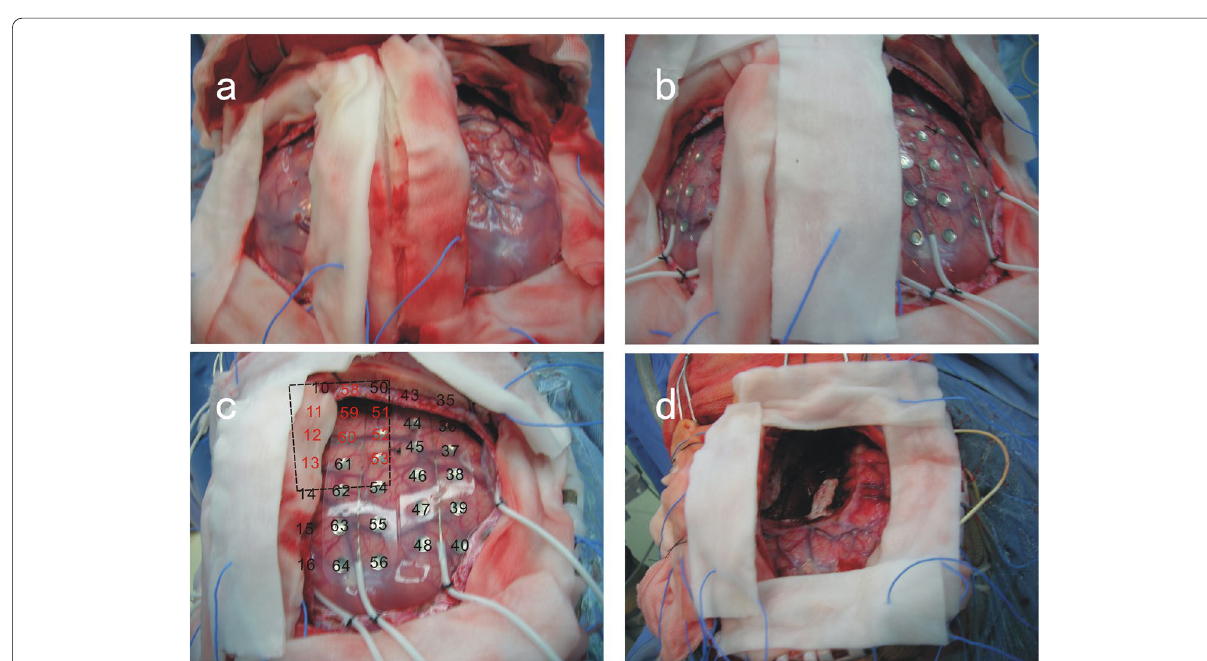
Fig. 1 Illustrations of implanted electrodes and site of resection in patient 1 (Numbers indicate channels for ECoG recording. Red numbers represent the seizure onset area according to ECoG analysis. Dashed lines in panel c show the resected area during surgery)